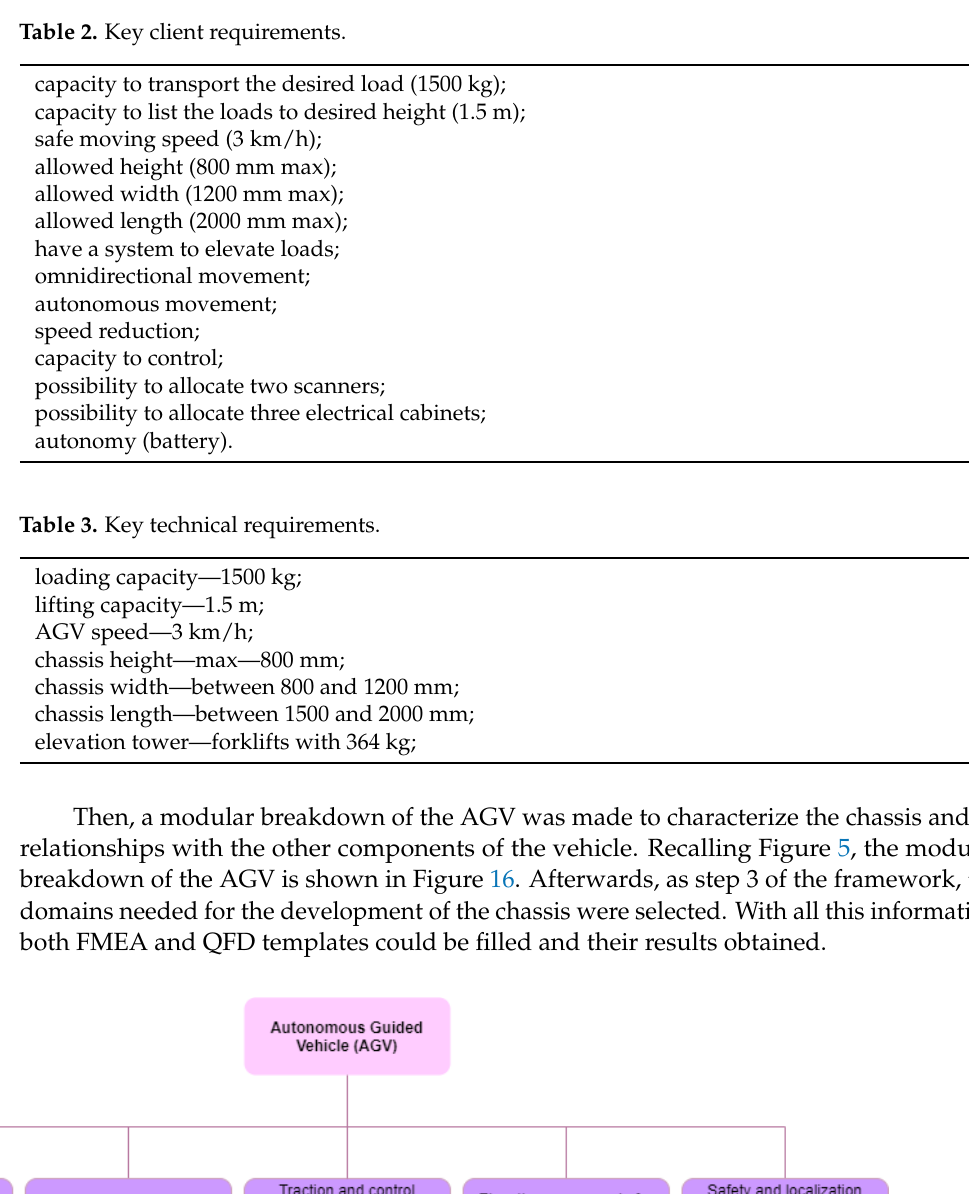
Table 2. Key client requirements.